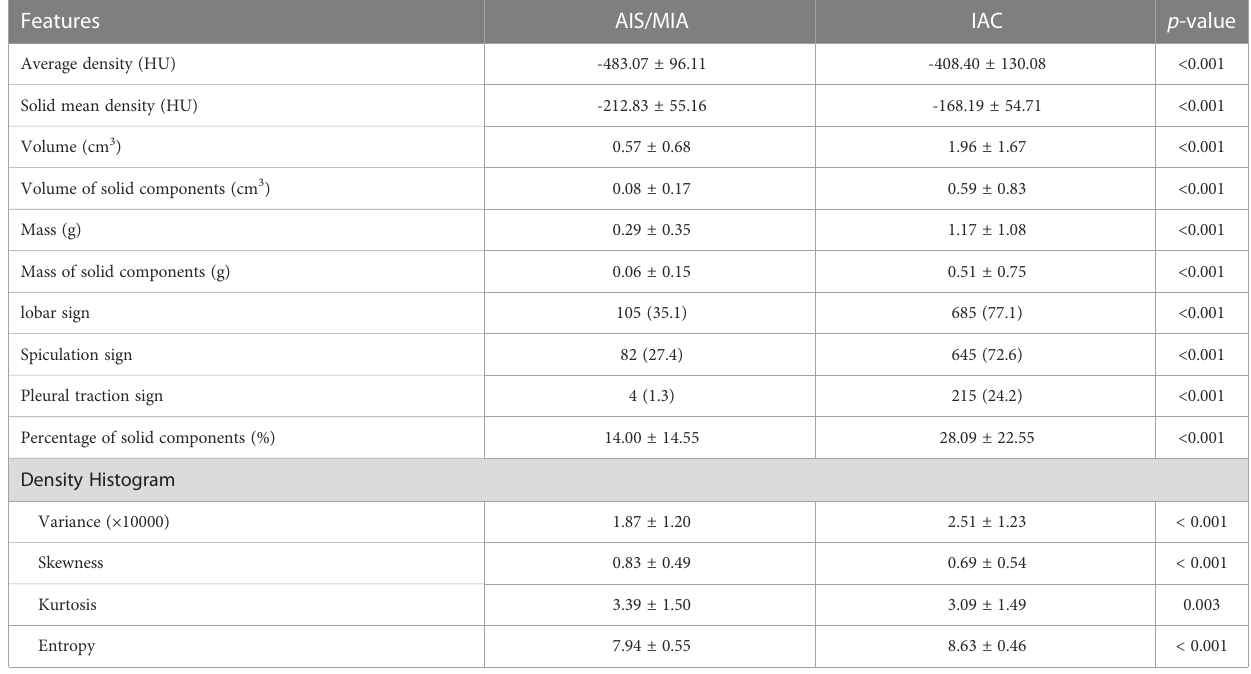
TABLE 2 Comparison of imaging features of AIS/MIA and IAC in 1,188 cases of PSNs. Features